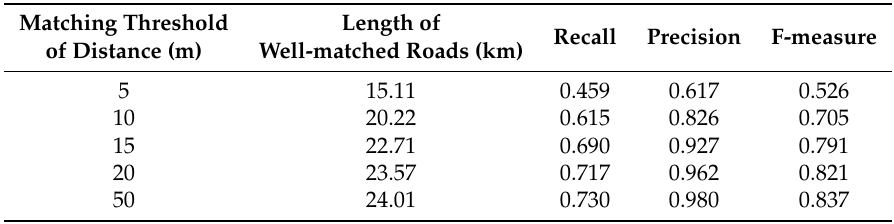
Table 1. Matching results of Biagioni and Eriksson’s method on the Chicago dataset.